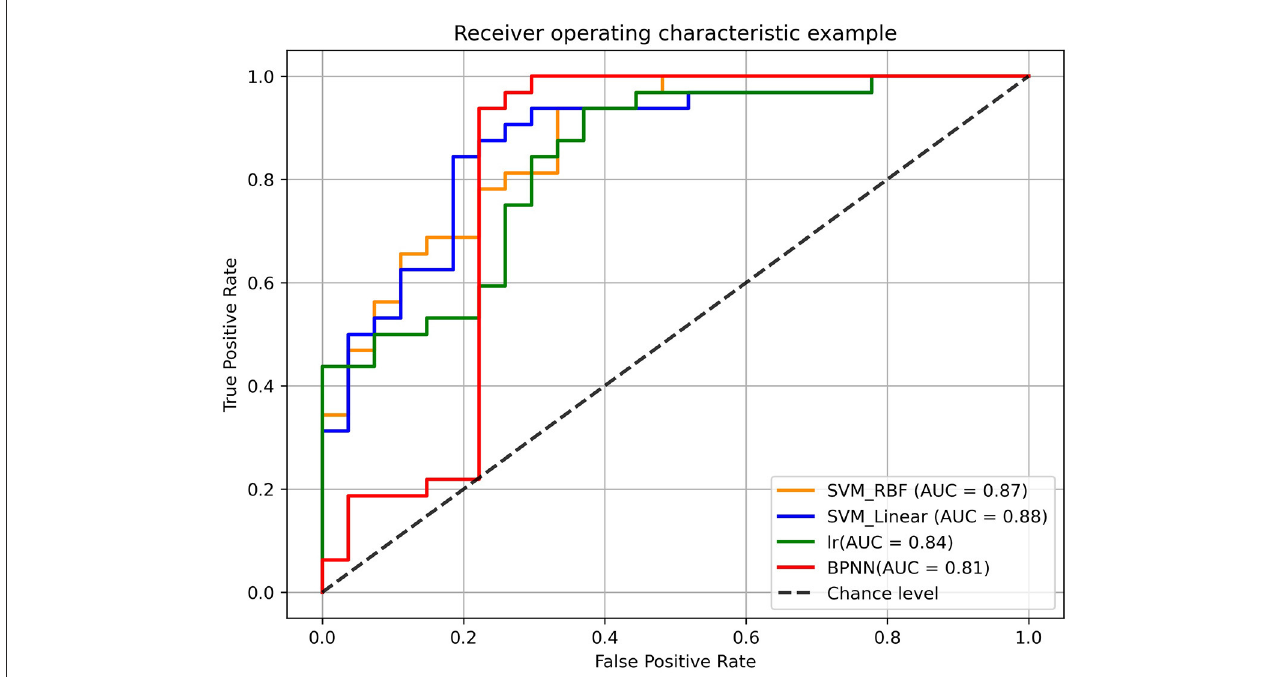
FIGURE5 The receiver operating characteristic (ROC) curves of different models. The orange curves, blue curves, green curves, and red curves represented the roc curve of SVM (RBF Kernel), SVM (linear Kernel), logistic regression (LR) model and back-propagation neural network (BPNN) model,